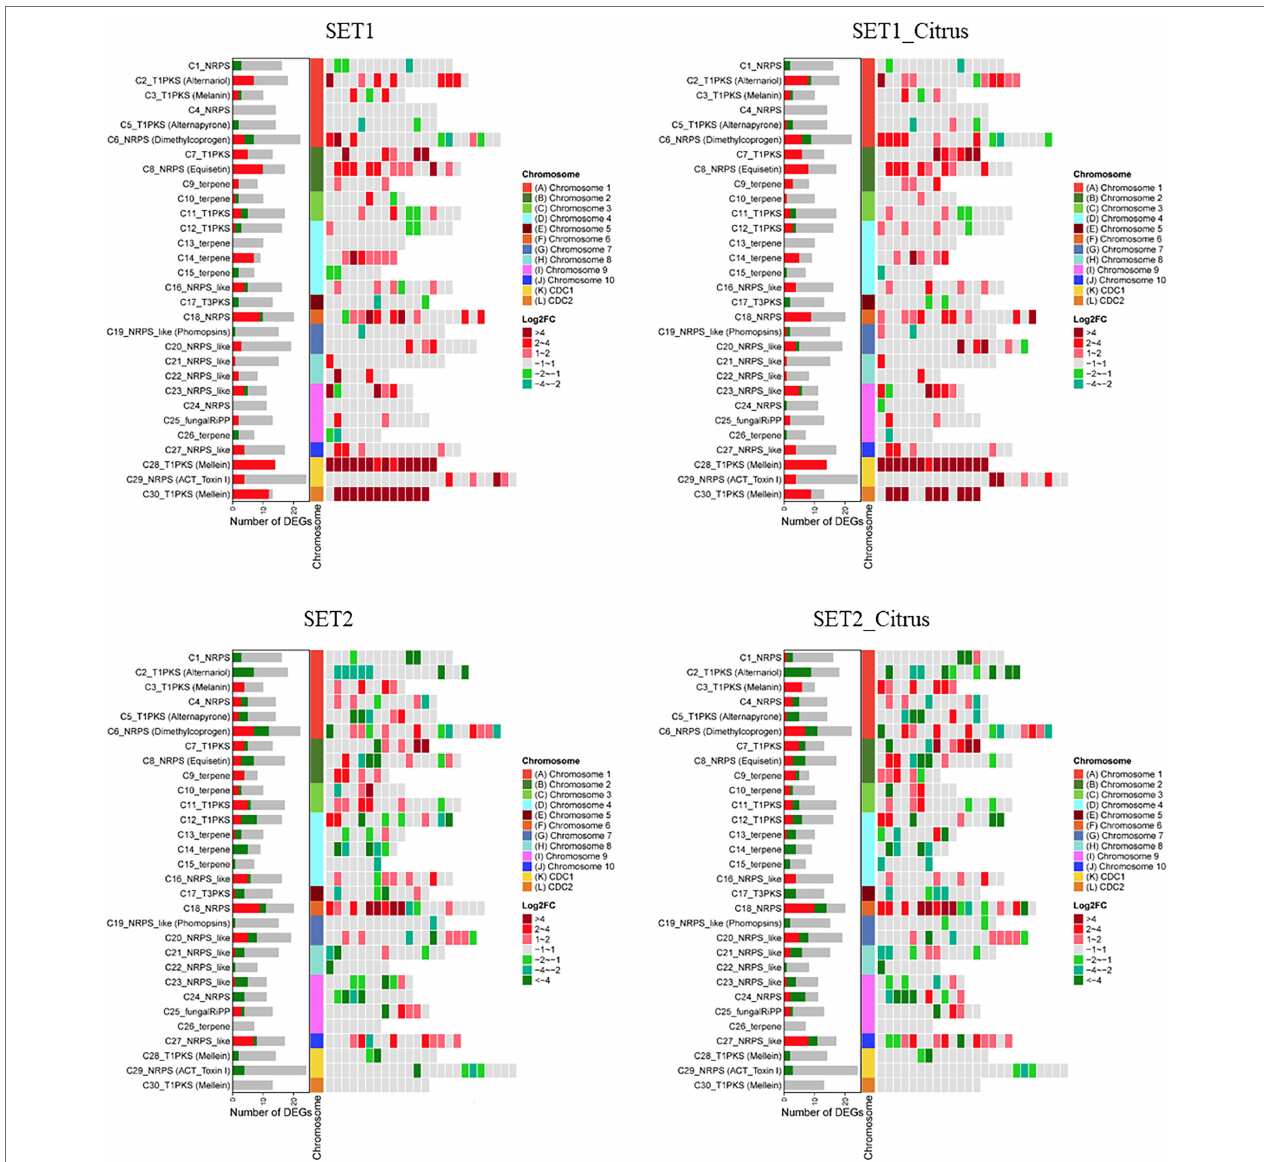
FIGURE 9 | Differential expression of gene clusters associated with the biosynthesis of secondary metabolites in ∆ AaSet1 and ∆ AaSet2 compared to wild type with or without the induction of citrus